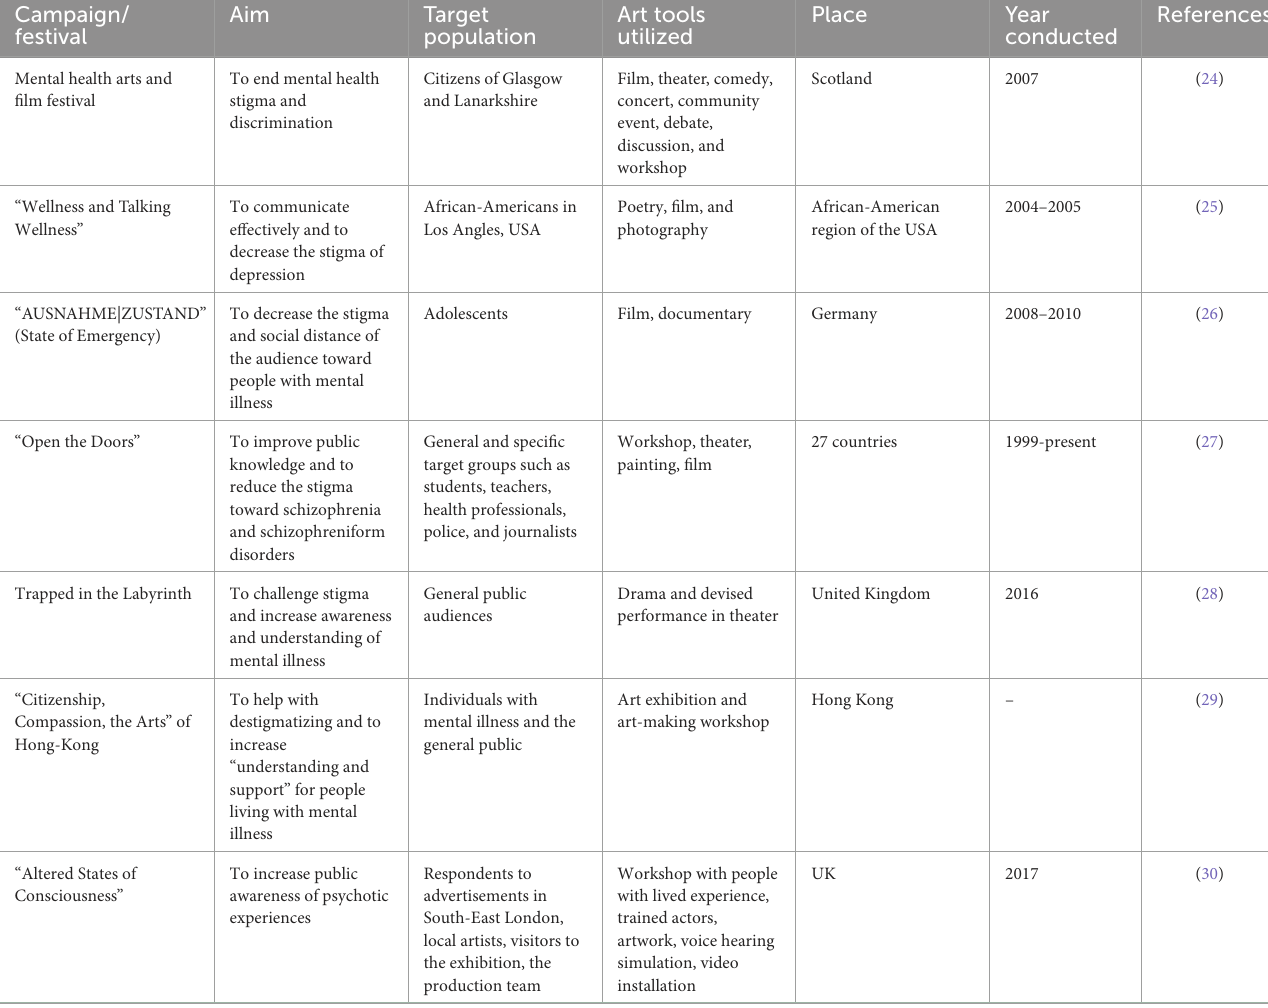
TABLE 1 A brief review of a number of destigmatizing art festivals with the main goal of increasing awareness about mental health disorders ∗ . Campaign/